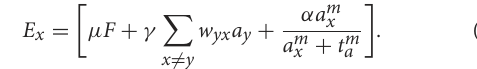
Table 1 along with default values. All equations were numerically integrated using Euler’s forward method with a fixed time step 1 t = 1 ms. The excitatory input to each neuron, E x ,